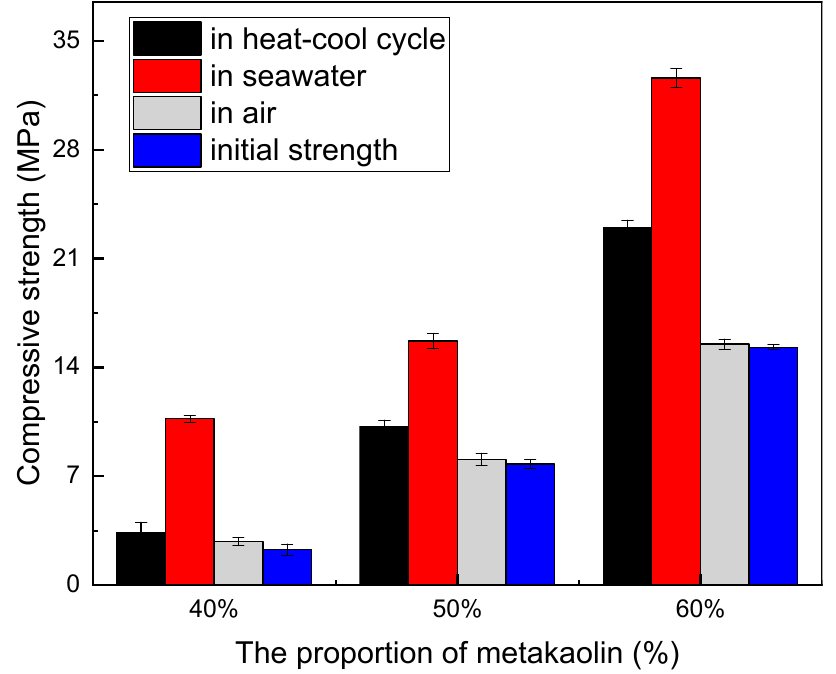
Figure 3. Compressive strength of the geopolymers prepared with different proportions of metakaolin and different exposures.